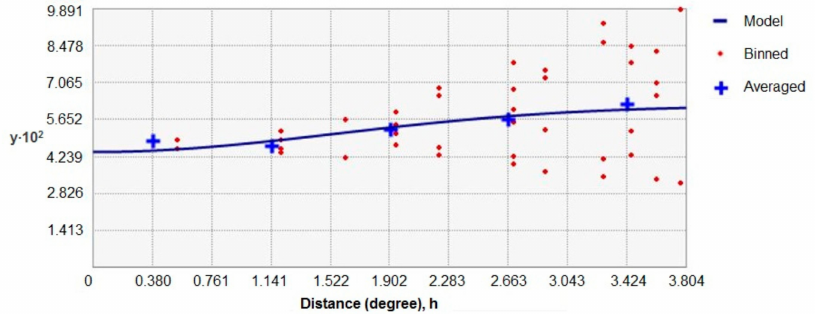
Figure 4. The Gaussian semivariogram model with 5 lags used for kriging the badger